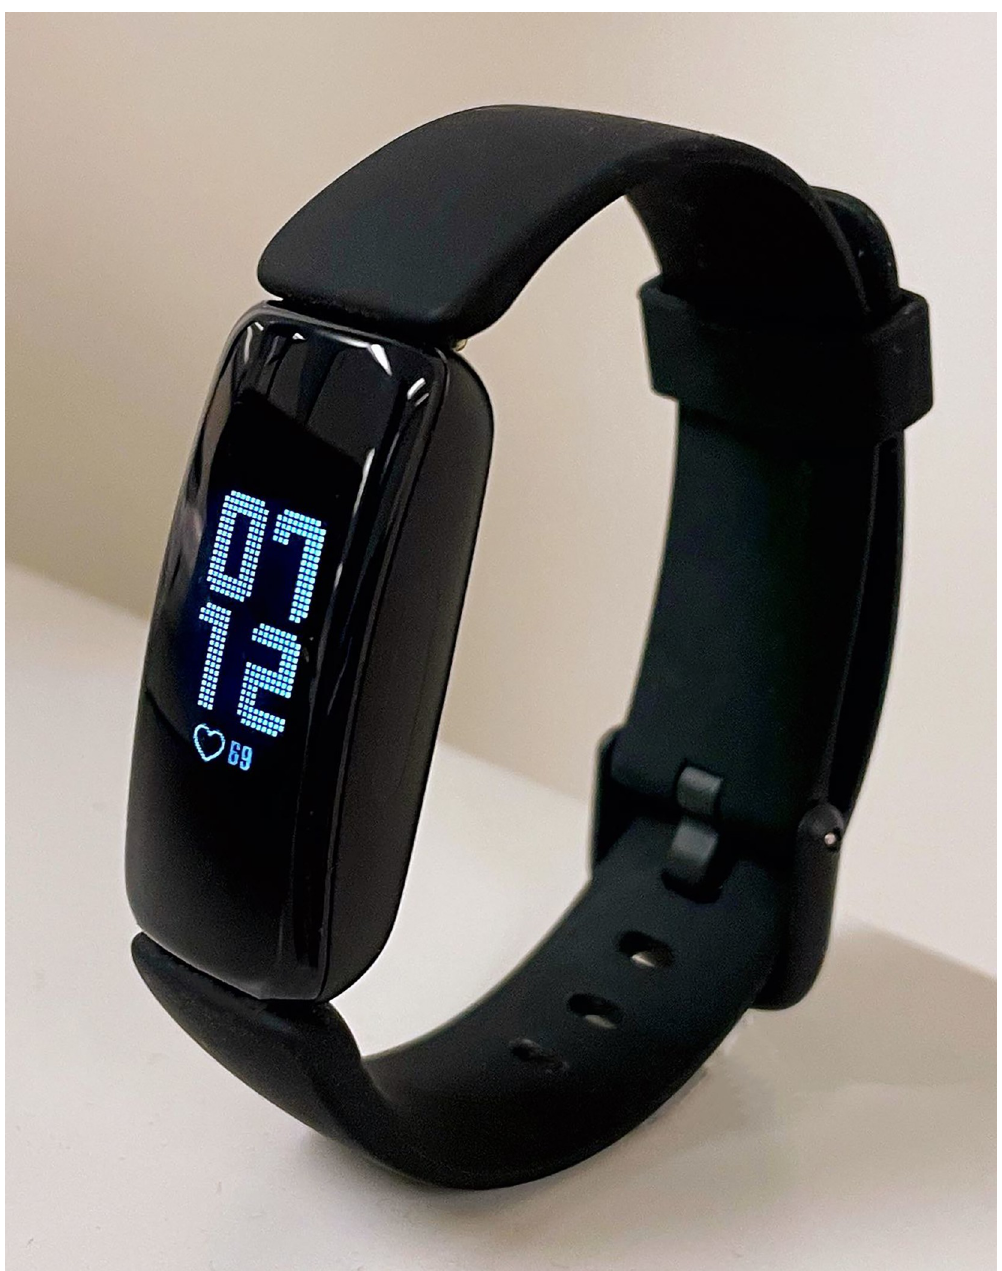
Fig 3. Fitbit Inspire 2 1 (San Francisco, IL). health, psychological health, social relationships, and environment [54]. Higher scores indicate greater perceived quality of life with grading on a five-point Likert scale. This scale has demon- strated strong psychometric characteristics of good reliability in the British SCI population (Cronbach’s α = 0.96) [26] and acceptable content validity in the Chinese context (r = 0.39– 0.65) [55].